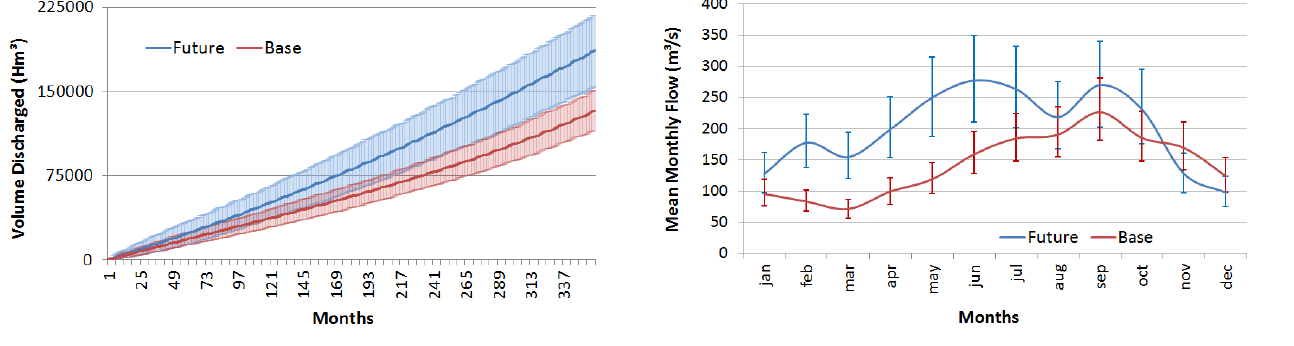
Figure 5. Mean and 90% confidence interval for the volume dis- charged, based on the stochastic series generated, base period (1961–1990) and future period (2011–2040), Santo Ângelo gauge station.